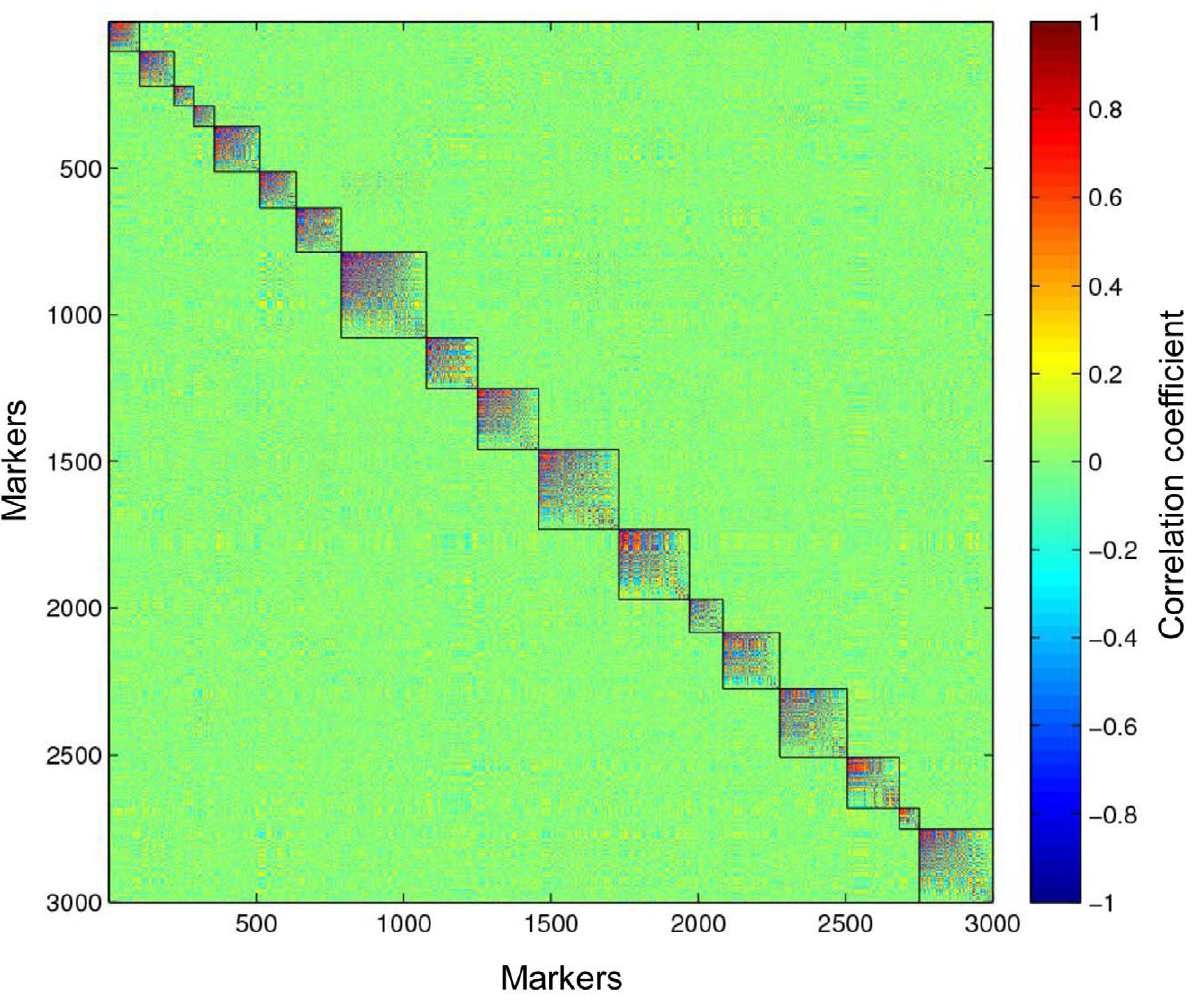
Figure 4. Eighteen paternal linkage groups identified in the full-sib tetraploid linkage population. Three thousand markers are clustered into 18 linkage groups, matching the haploid number of chromosomes in switchgrass. The color scale represents the Spearman’s rank correlation between markers.